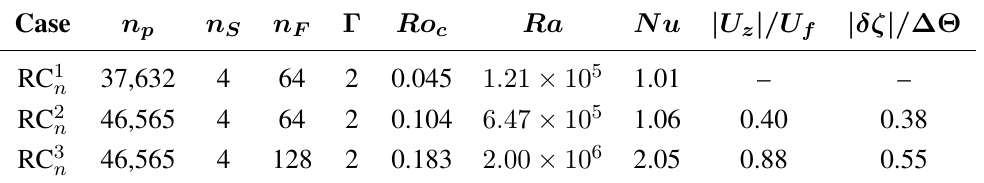
Table 8. Input and output parameters for the numerical RC cases. The Ekman and Prandtl numbers have fixed values of E = 2 . 05 × 10 − 5 and P r = 0 . 025 ,